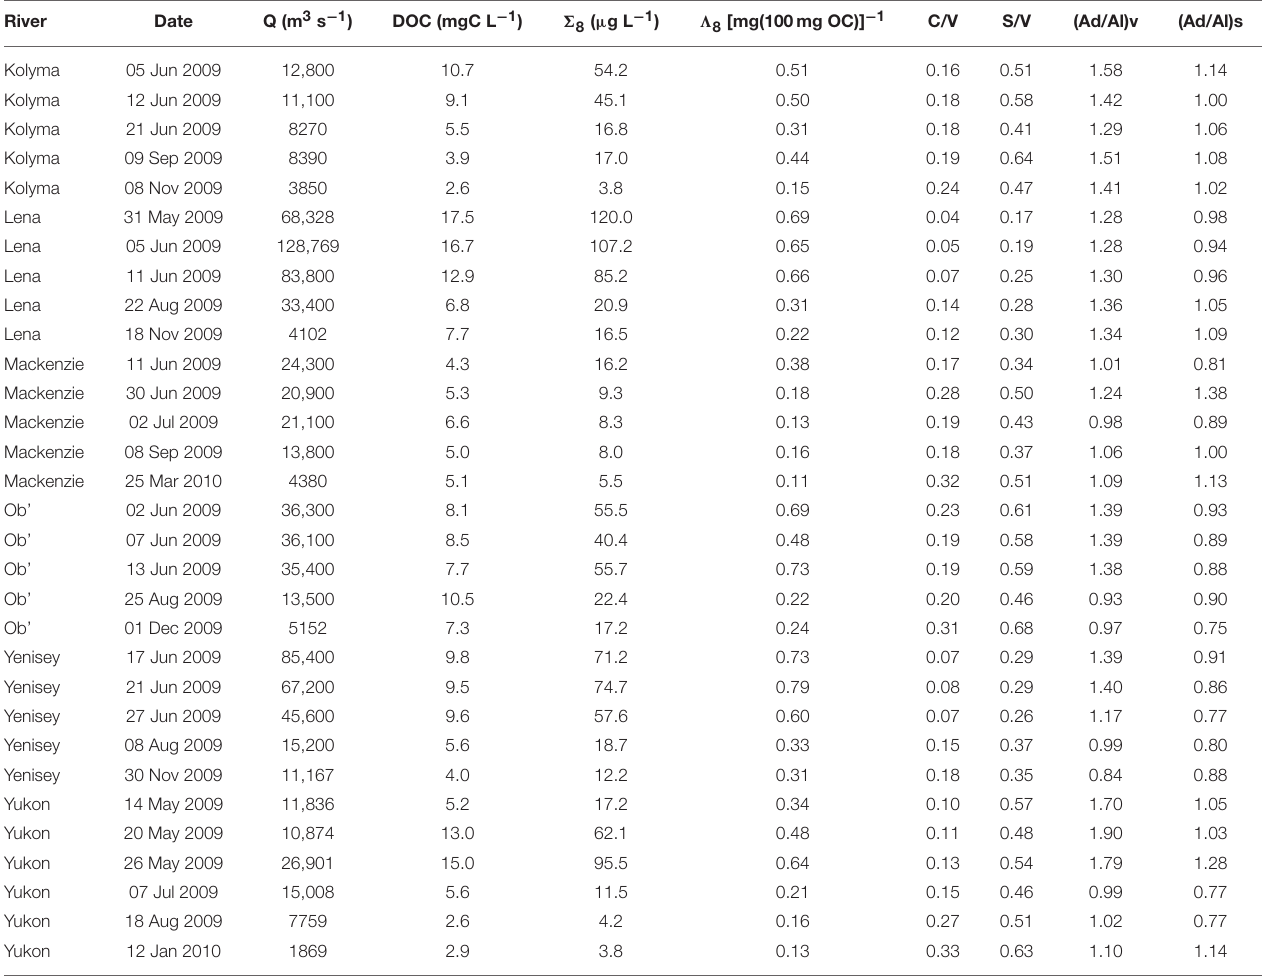
TABLE 2 | Sampling location and date of dissolved organic carbon (DOC) and lignin phenol concentration ( 6 8 ), carbon normalized sum of lignin yields ( 3 8 ), lignin ratios (C/V and S/V), and acid aldehyde ratios (Ad/Al) measurements. Site-normalized discharge (Q) is also